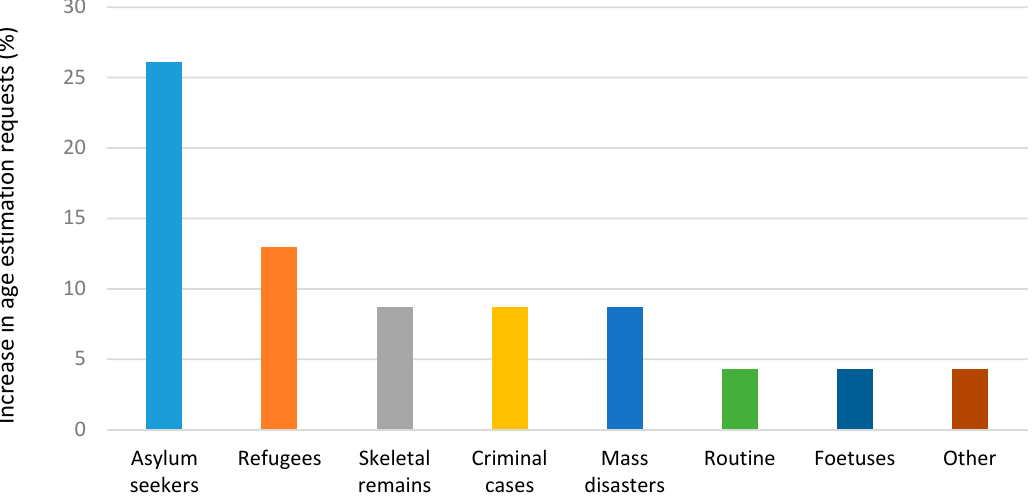
Figure 3. Percentage increase in the number of requests per category (%).